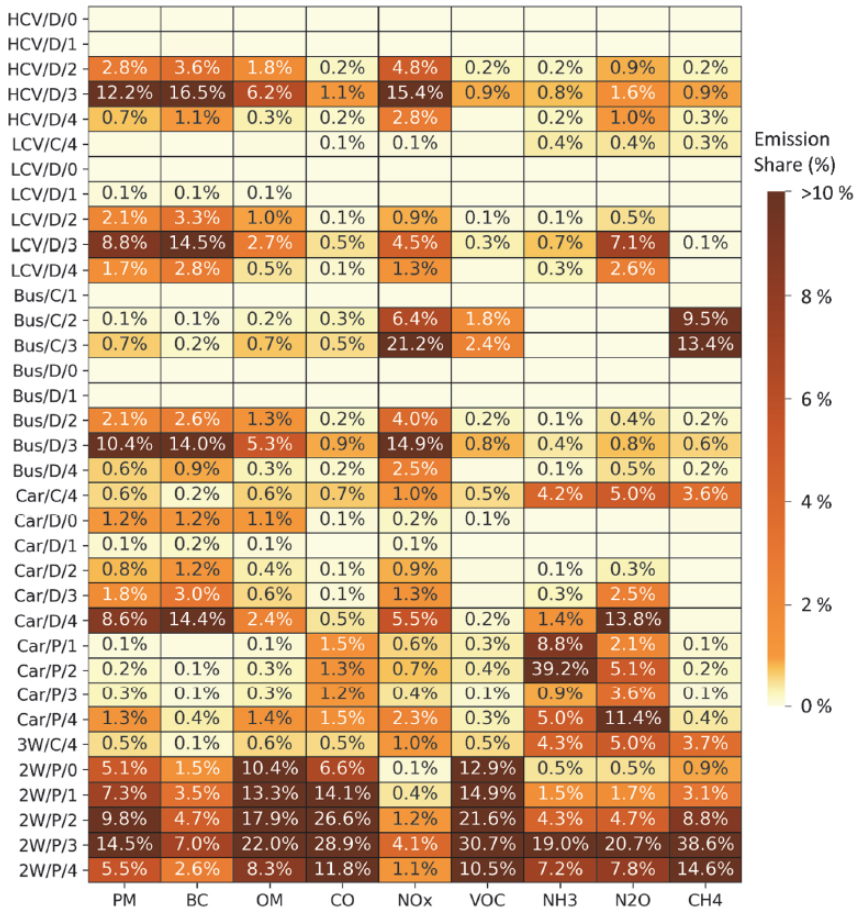
Table 4. Emission share of vehicles of different class, fuel and BS/EURO standards. Contributions less than 0.1% are not shown here. Contributions more than 10% are shown in the same colour. (D: diesel, P: petrol, C: CNG and number 0–4 represents the Euro type starting from 0 being conventional to 4 as Euro